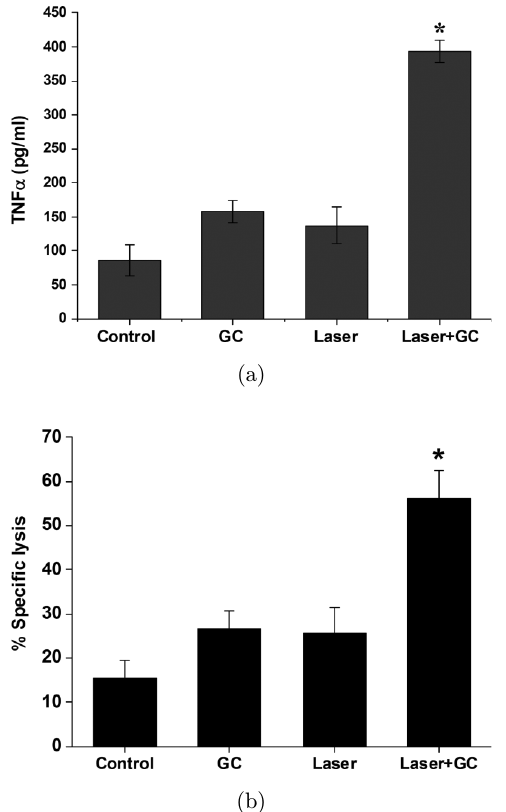
Fig. 3. Induction of anti-tumor immunity by di®erent treat- ments. (a) TNF- (cid:1) secretion by mouse splenocytes. Seven days after di®erent treatments as indicated, splenocytes from treated mice were harvested and restimulated with mitomycin C-trea- ted EMT6 cells for 2 days and their TNF- (cid:1) secretion was detected by ELISA. The levels of TNF- (cid:1) secretion by spleno- cytes from mice treated by laser þ GC were noticeably higher than that from mice of the other treatment groups. Bars, means (cid:2) SD ( n ¼ 5), * p < 0 : 05. (b) Tumor cytotoxicity of splenocytes from treated mice. Harvested splenocytes were restimulated with mitomycin C-treated EMT6 cells, stained by calcium acetoxymethyl, for 5 days. Cytolytic activity against EMT6 cells was tested by °uorescence assay. Bars, means (cid:2) SD ( n ¼ 4), * p < 0 : 05.